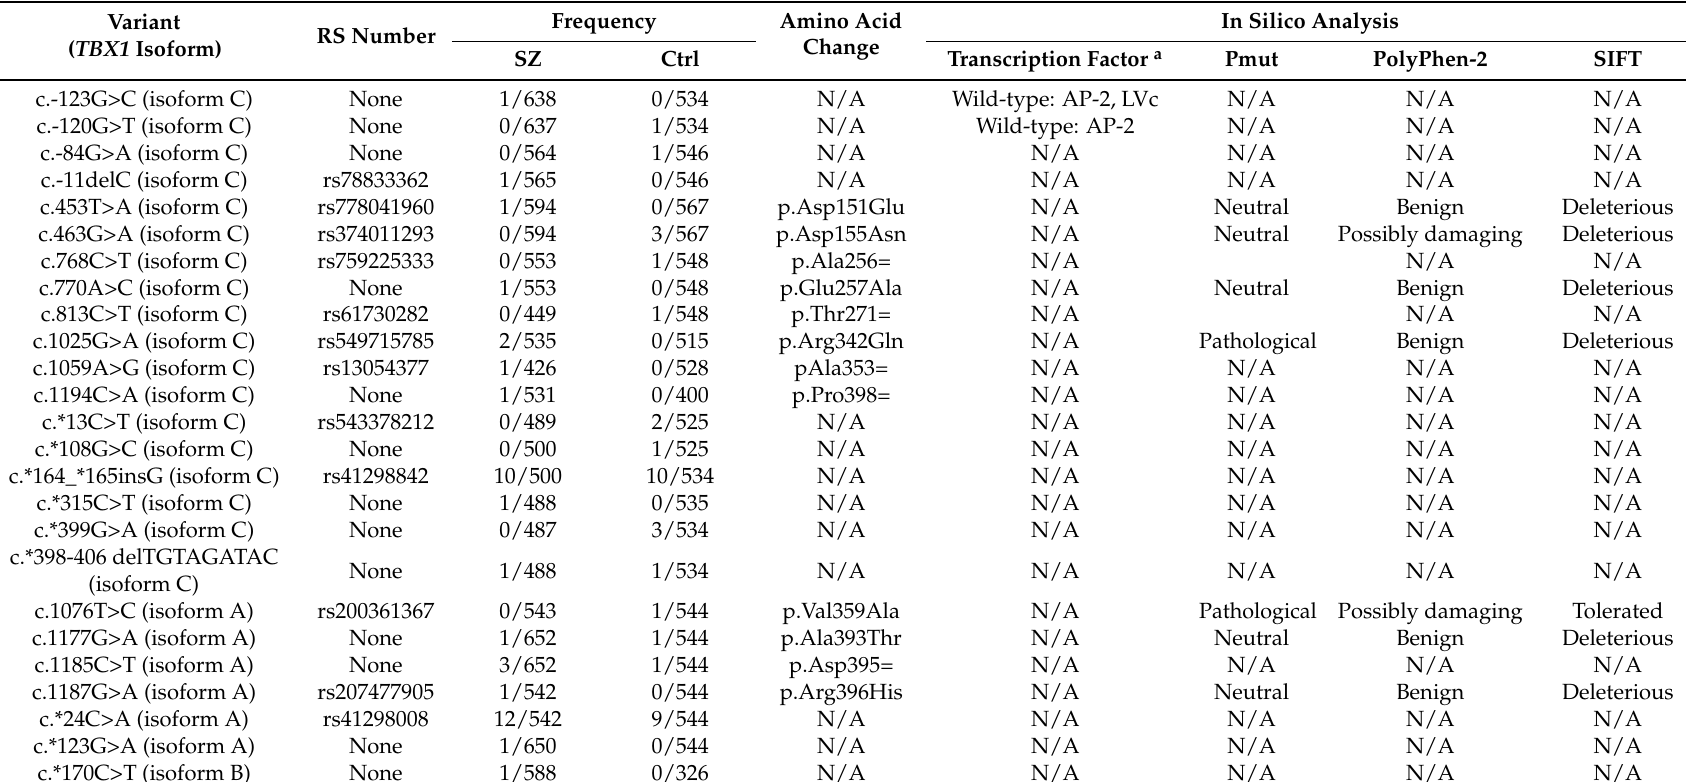
Table 2. Distributions and bioinformatics analyses of rare mutations in the TBX1 gene identified in this study.